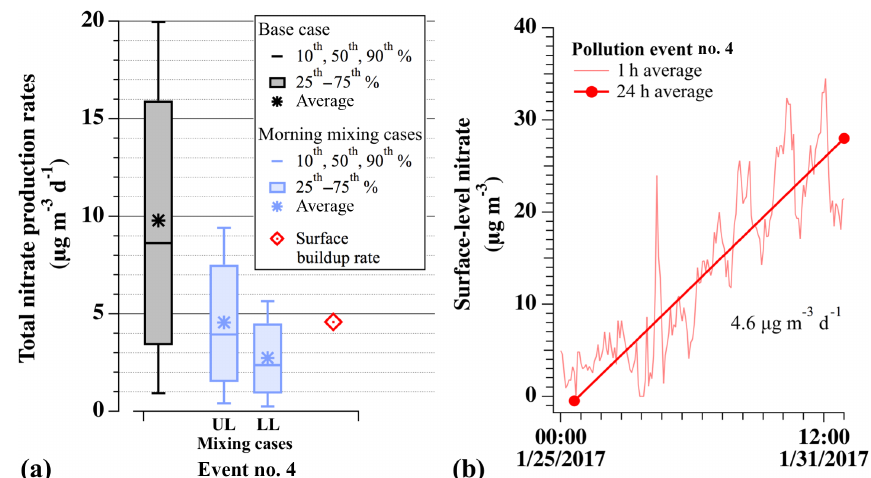
Figure 10. (a) For pollution event no. 4, comparison of model-predicted nocturnal nitrate production (µgm − 3 d − 1 ) for base case simulations (gray), simulations with 24h of dilution (blue), and the average daily nitrate buildup observed at HW (red). Dilution cases are for simulations that incorporate nocturnal dilution rate constants of 1 . 2 × 10 − 5 (L), 1 . 3 × 10 − 5 (M), and 2 . 5 × 10 − 5 (H)s − 1 , scaled by 60% during the day. Box-and-whisker plots show the 10th–90th percentile distributions of each set. Upper-limit (UL) values assume morning mixing between equivalent nitrate concentrations produced in the RL and NBL. Lower-limit (LL) values assume morning mixing with no nitrate production in the NBL. The red diamond shows the ground-based buildup rate, calculated from 24h averaged data at HW in panel (b) . (b) Observed concentrations and average daily buildup rate of nitrate aerosol mass (total mass · 0.58) at HW during event no.